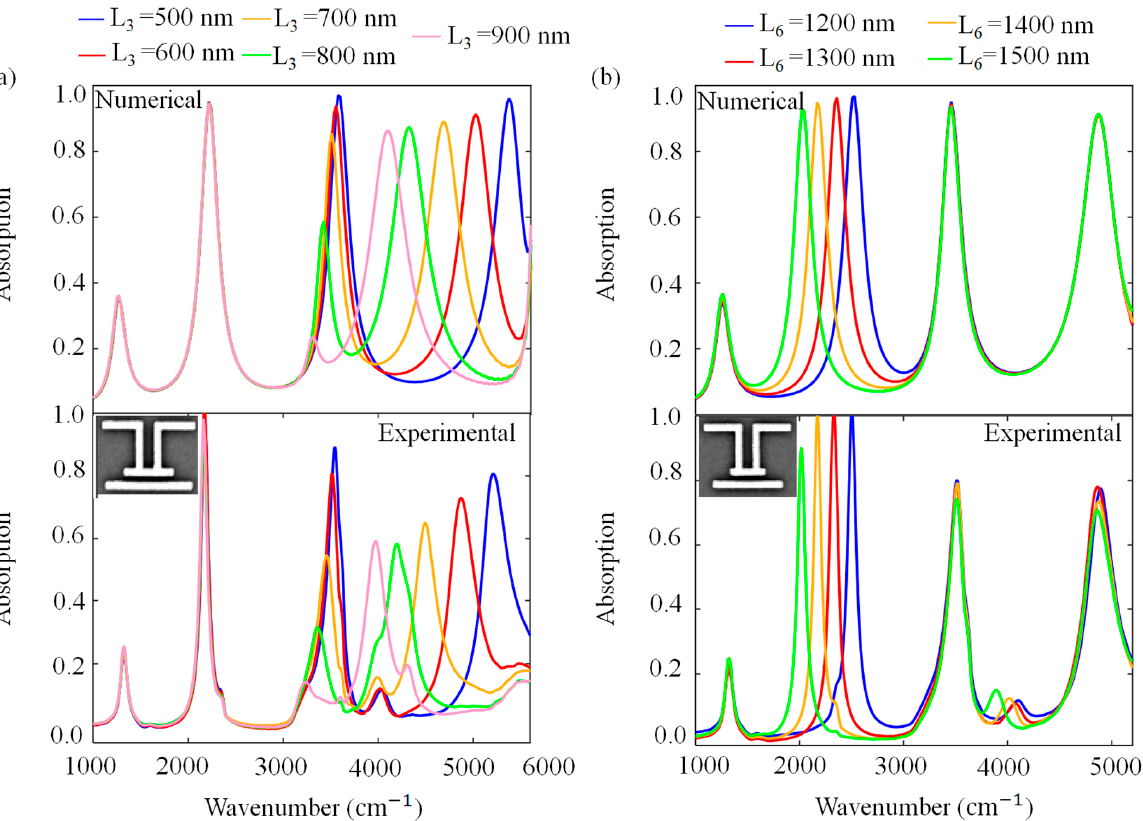
Figure 4. Absorption spectra of the PA platform for ( a ) numerical and experimental results of L 3 sweep; ( b ) numerical and experimental results of L 6 sweep under x-polarized light source. The results support the near-field enhancement distributions at various resonance frequencies. The insets show the SEM image of unit cell for L 3 = 800 nm and L 6 = 1200 nm. Array periodicity is 1.7 µm.